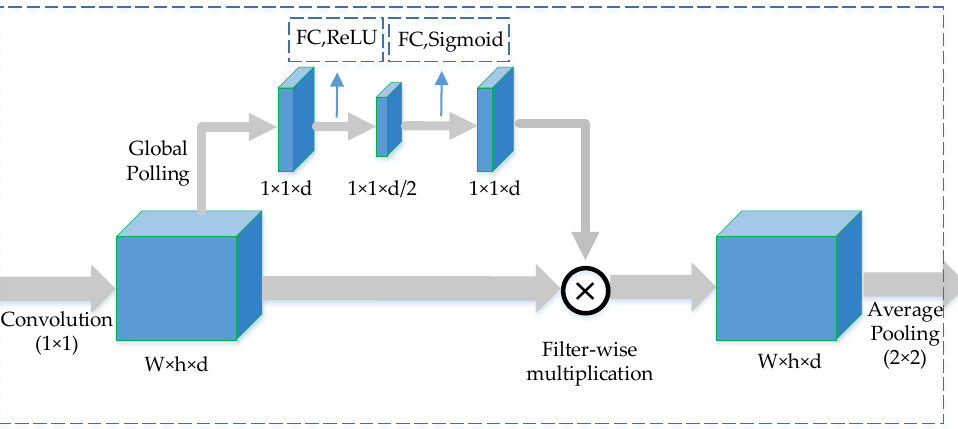
Figure 6. The transition down layer in down sampling process, it consists of convolution layer, fully connected layer and average pooling layer. 𝑊,ℎ and 𝑑 are width, height and depths of feature maps, respectively.